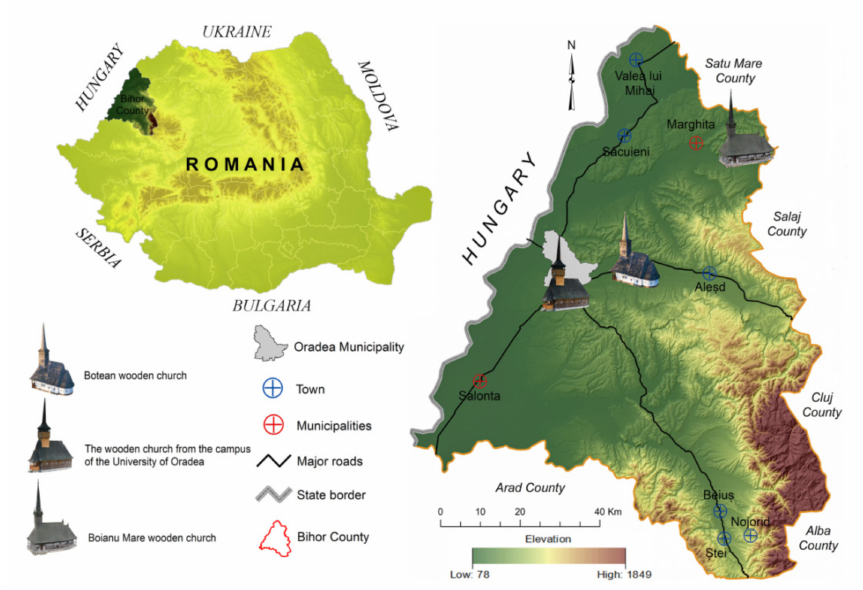
Figure 1. The location of the three church case studies at the level of Bihor County and Romania. Located on a headland, in the centre of Boianu Mare village (82 km from the